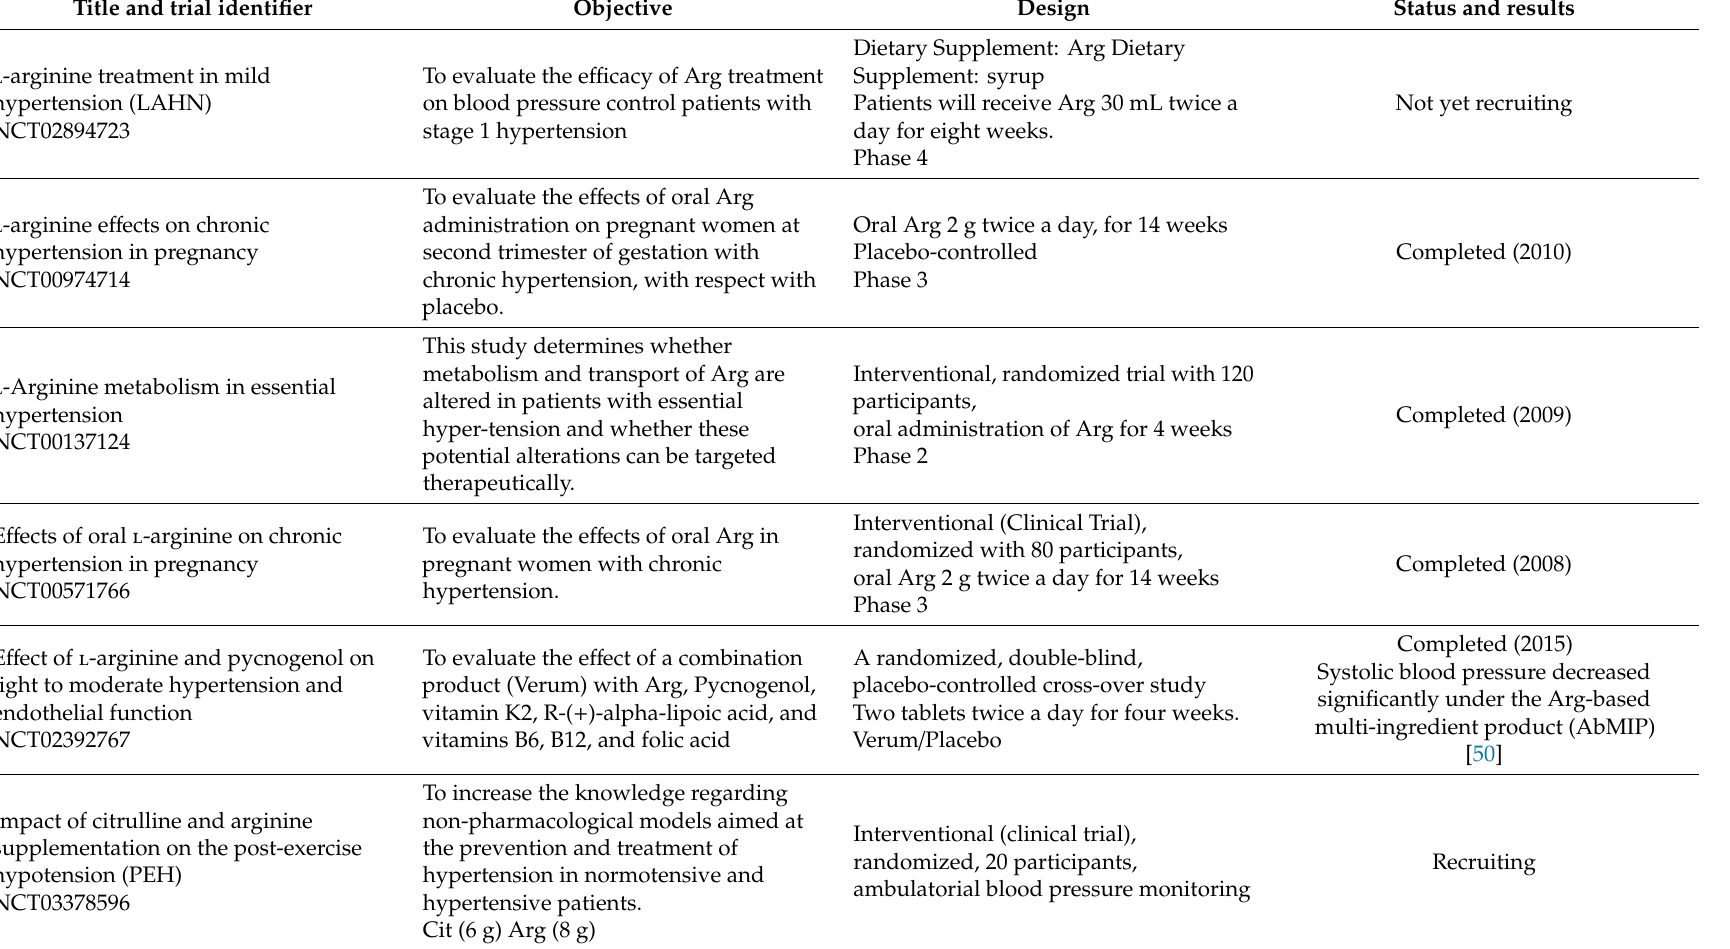
Table 2. A list of clinical trials investigating the e ffi cacy of l -arginine on hypertension (https: // clinicaltrials.gov), last accessed on 12 July